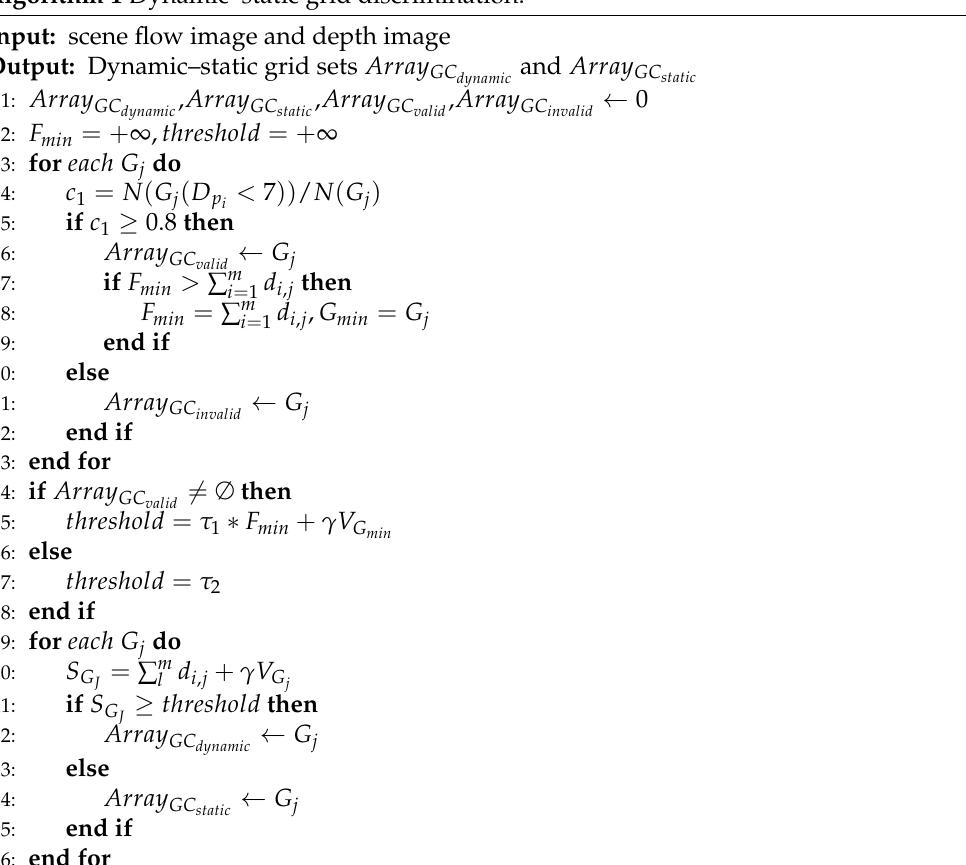
Algorithm 1 Dynamic–static grid